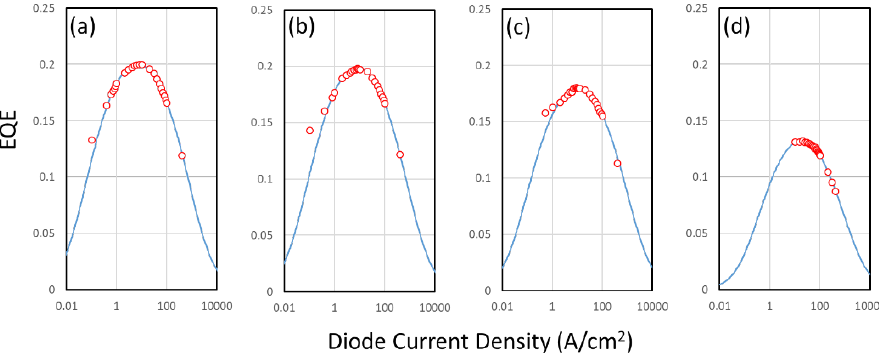
Figure 4. The measured (dots) and the calculated (line) results of devices of ( a ) 100 µ m, ( b ) 50 µ m, ( c ) 25 µ m, ( d ) 10 µ m. Table 1. The extracted SRH coefficient and leakage